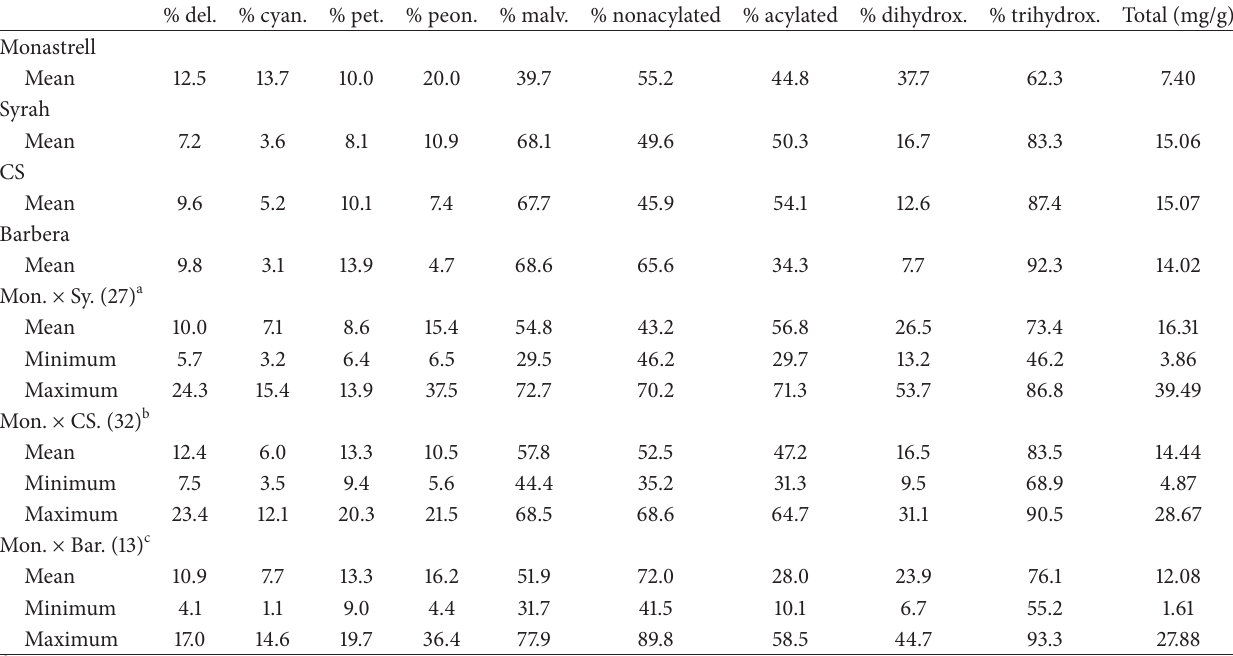
a,b,c The number in parenthesis represents the number of hybrids for each